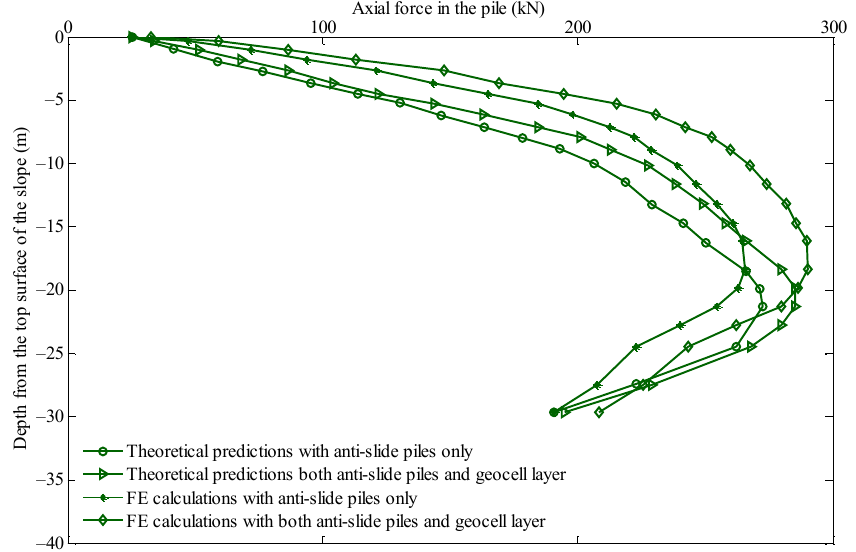
Figure 13. Depth-dependent axial force in the No. 1 anti-slide pile.